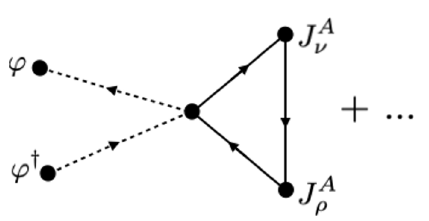
Figure 4 . Triangle diagrams entering the second correlator in eq. (A.2) in the unbroken phase (the + . . . refers to the same diagrams with the orientation of the fermionic arrows reversed). Solid lines are fermion propagators and dashed lines are scalar